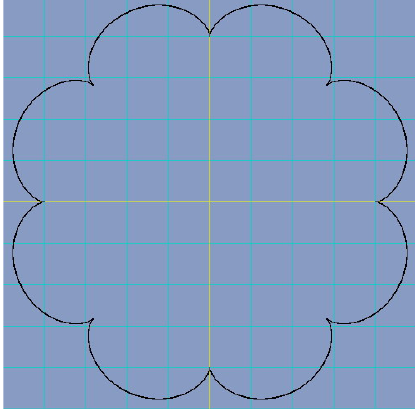
Figure 4. Epicycloid for values a = 200 and b = 25.